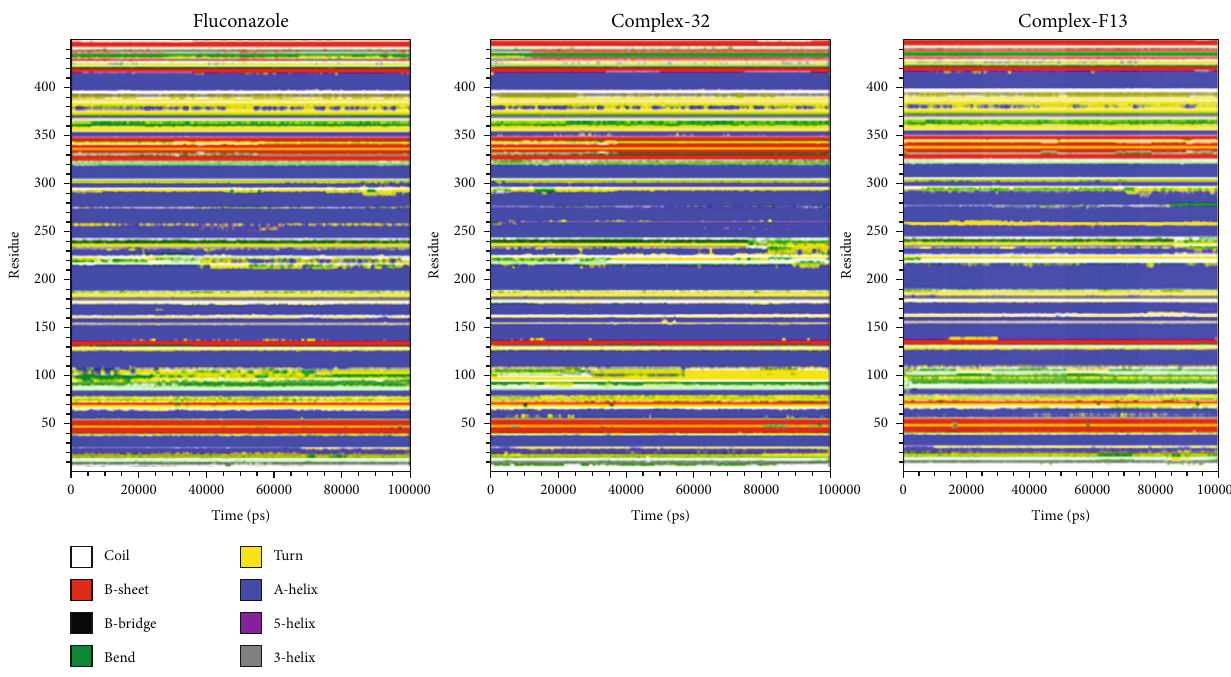
Figure 13: The secondary structure during molecular dynamic simulation. Table 4: The secondary structure during molecular dynamic